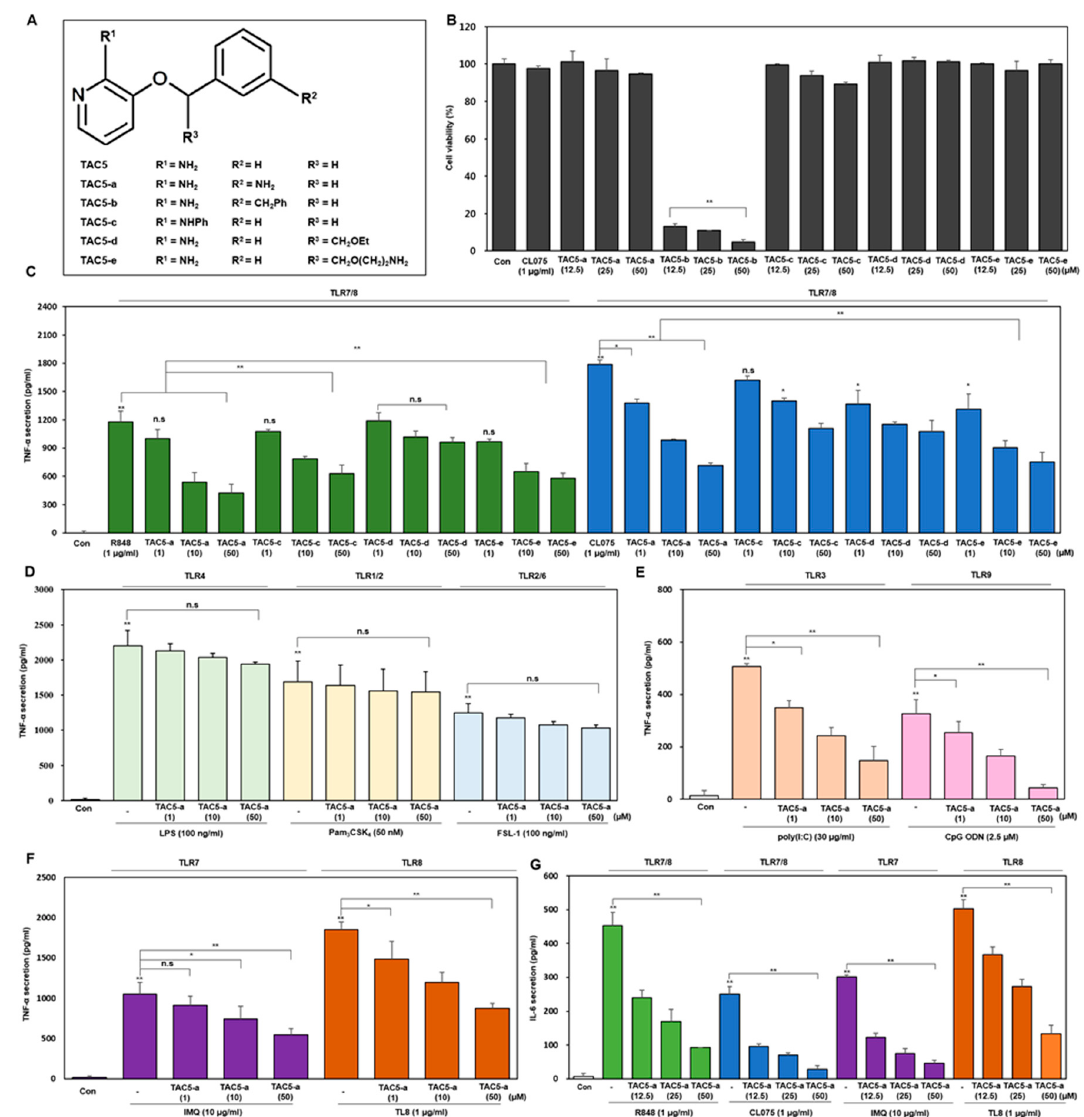
Figure 3. Inhibitory effect of TAC5-a on the TLR signaling pathways. ( A ) The chemical structure of TAC5 and its derivatives represented by different R groups. ( B ) RAW 264.7 cells were treated with various concentrations of compounds for 24 h and the cell viability was measured using an MTT